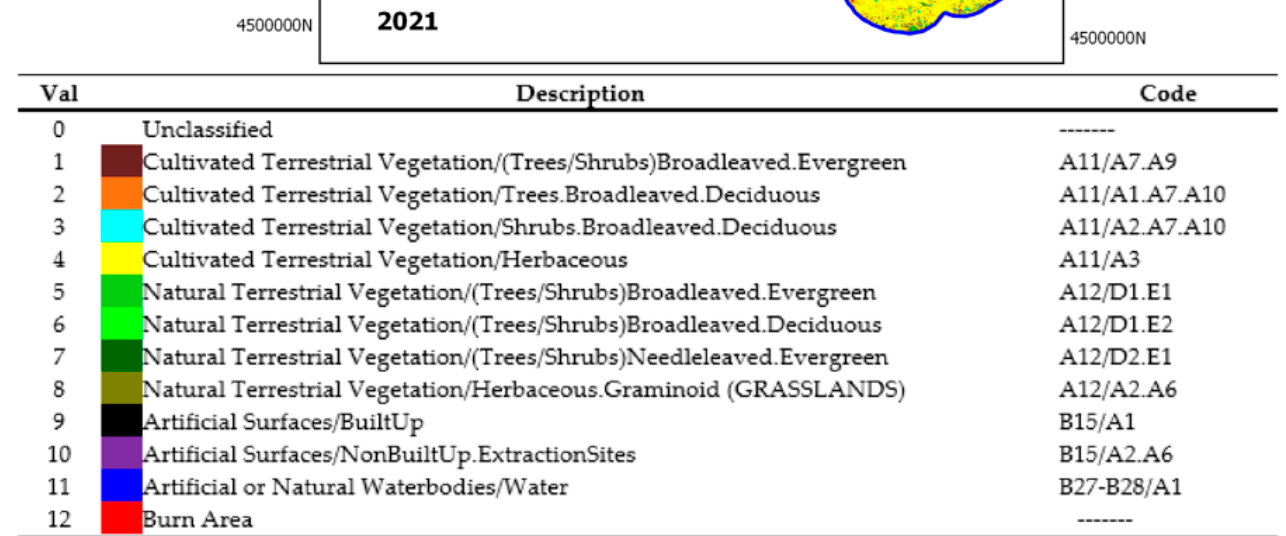
Figure 6. Multi-class LC mapping for 2021 and its legend in FAO-LCCS2